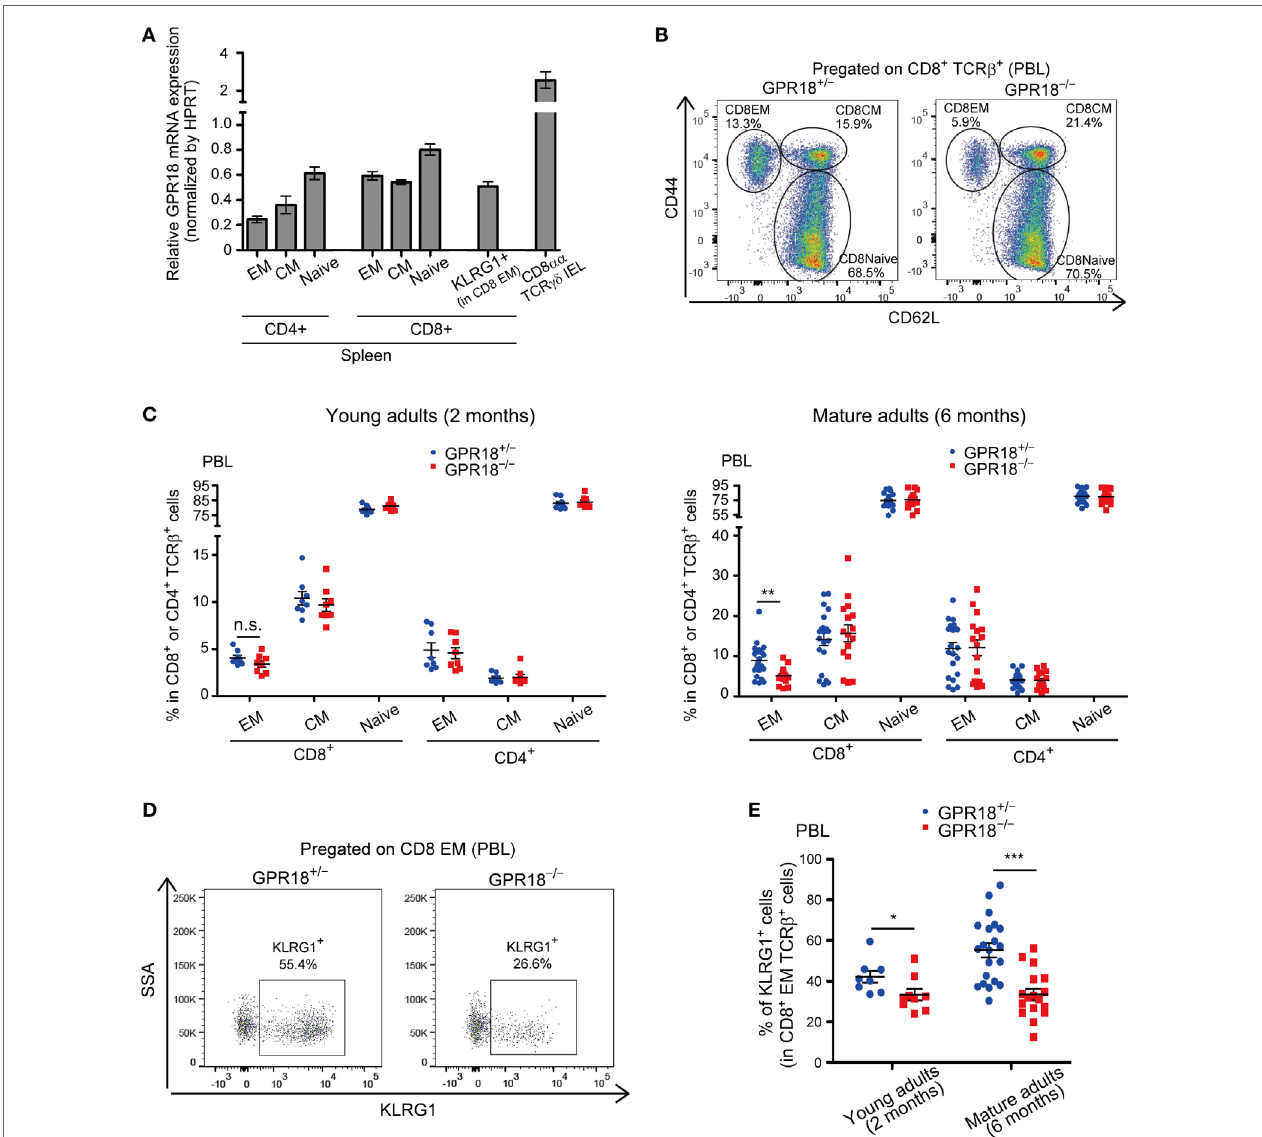
FigUre 1 | Reduction of KLRG1 + CD8 EM T cells in G-protein-coupled receptor 18 (GPR18)-deficient peripheral blood lymphocytes (PBL). (a) Gpr18 transcript abundance in the indicated cell subsets relative to Hprt . Each point indicates cells sorted from an individual mouse and lines indicate mean ± SEM. n = 3 or 4 in each populations. EM, effector-memory; CM, central memory; IEL, intraepithelial lymphocytes. (B) Flow cytometric analysis of CD44 and CD62L expression in CD8 +